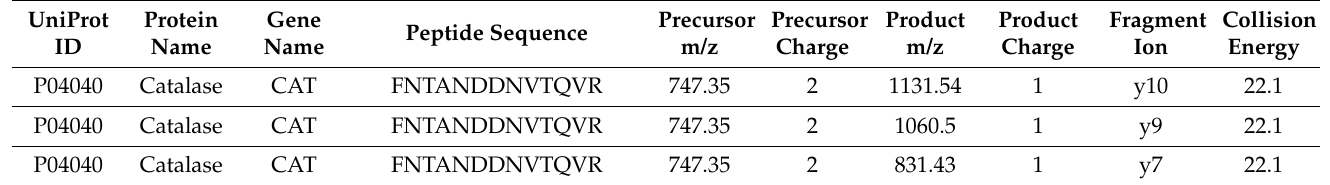
Table 1. Multiple reaction monitoring (MRM) assay. Transitions (Product m/z) for catalase measurement are listed. UniProt ID